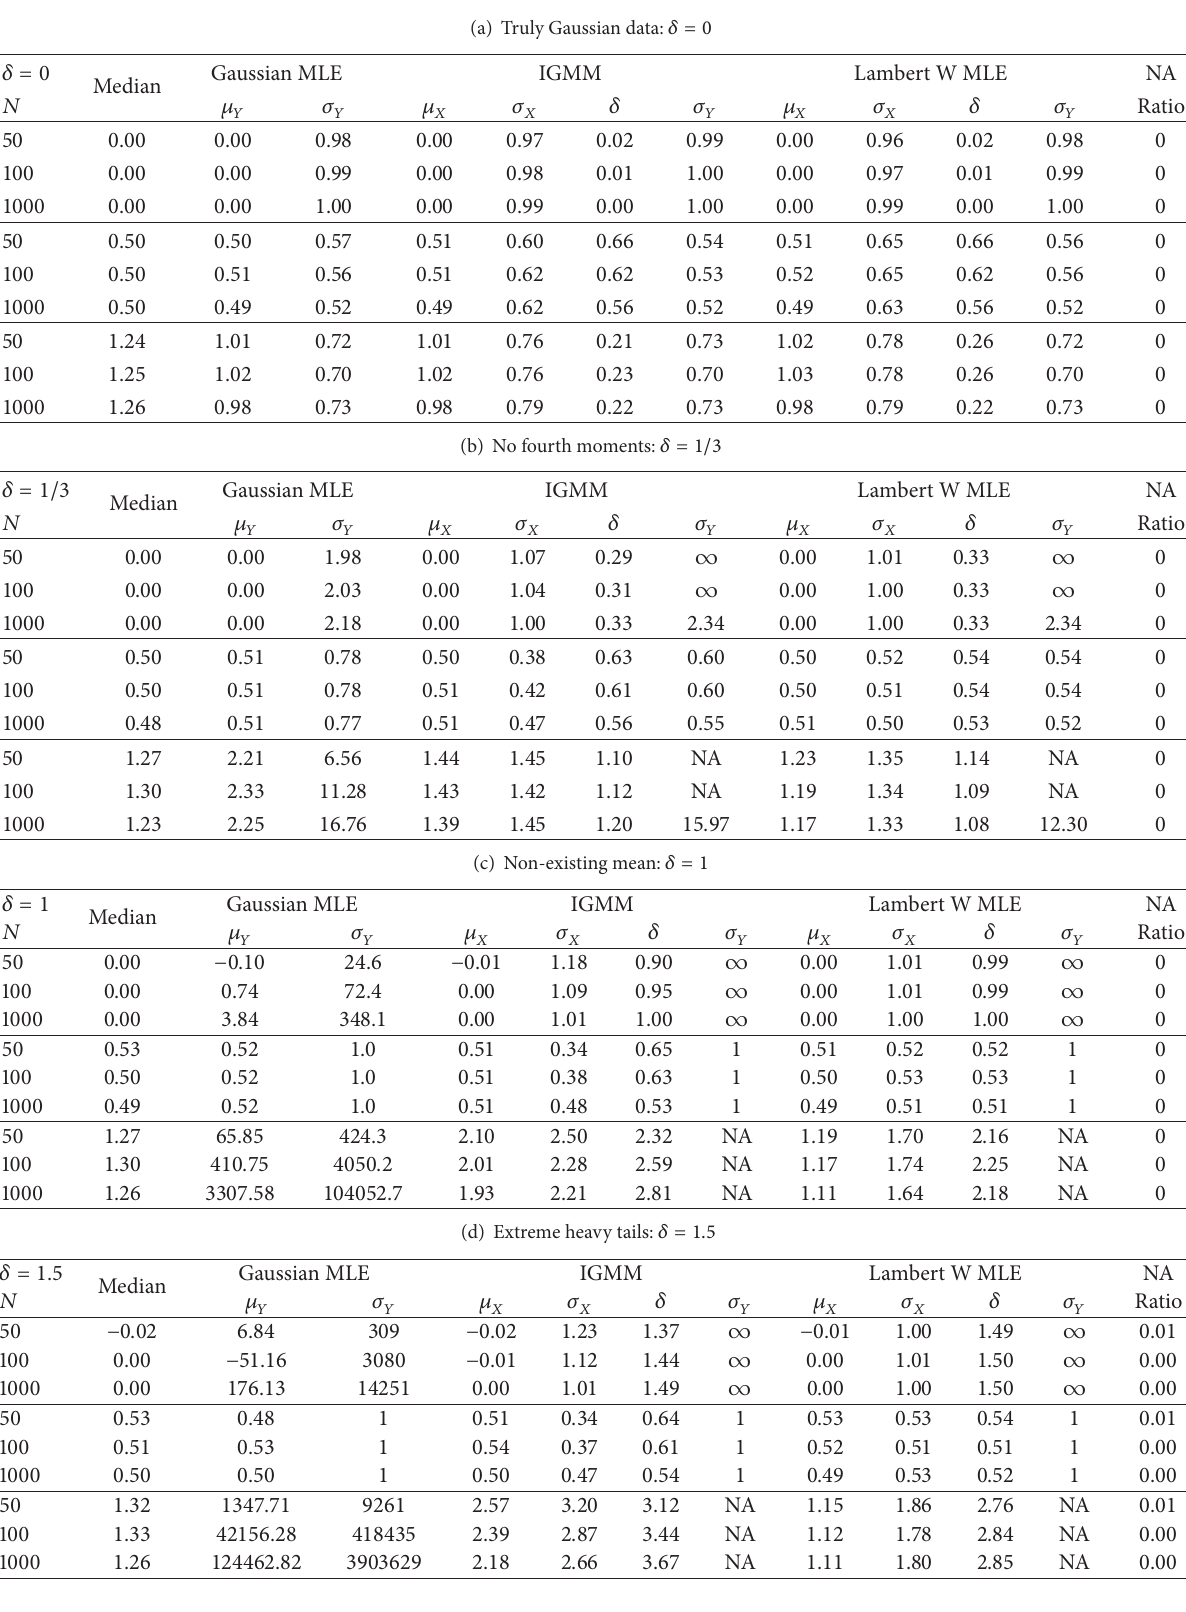
Table 2: In each subtable: (first rows) average, (middle rows) proportion of estimates below truth, and (bottom rows) empirical standard deviation times √𝑁 . True 𝜇 𝑋 = 0 and 𝜎 𝑋 = 1